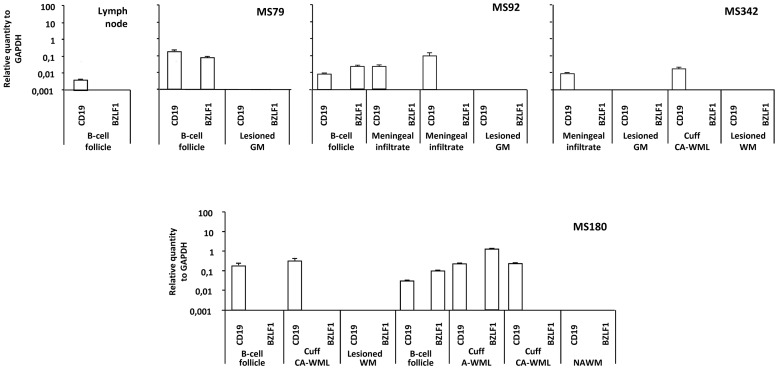
BZLF-1 gene expression in MS brain immune infiltrates.RNA was extracted from the indicated areas microdissected from sections of a control lymph node and from brain sections of 4 MS cases (MS79, MS92, MS342, MS180). Quantitative real-time RT-PCR for BZLF-1, for CD19 and GAPDH was performed following pre-amplification of cDNAs, as described in Materials and methods. Data for BZLF-1 and CD19 are normalized for the GAPDH level of expression. BZLF-1 mRNA was detected in 3 out of 4 meningeal B-cell follicles and in the perivascular cuff of an active white matter lesion (cuff A-WML), but not in lymph node, perivascular cuffs of chronic active WM lesions (cuff CA-WML), demyelinated white matter parenchyma (lesioned WM), demyelinated grey matter parenchyma (lesioned GM), and normal-appearing white matter (NAWM). The presence of CD19 signal indicates that the microdissected region includes a B-cell containing immune infiltrate. Values are means ± SD of triplicate values.